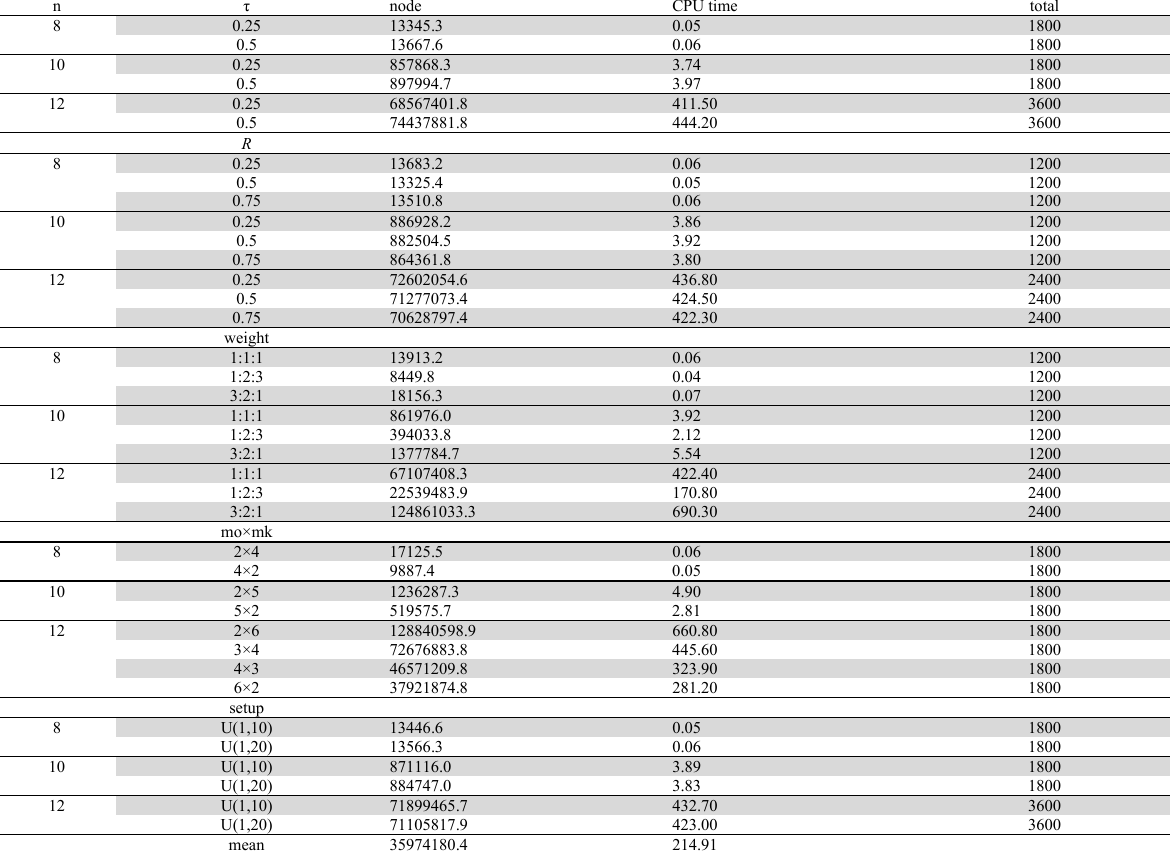
Performance of the branch-and-bound method